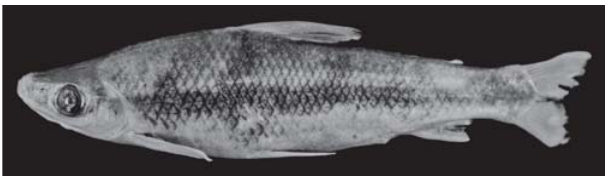
Fig. 8. Adult specimen of Laemolyta fernandezi , ANSP 166532, 137 mm SL; Venezuela, Bolivar, rio Orinoco basin, San Pedro de Tauca, L. Madera.